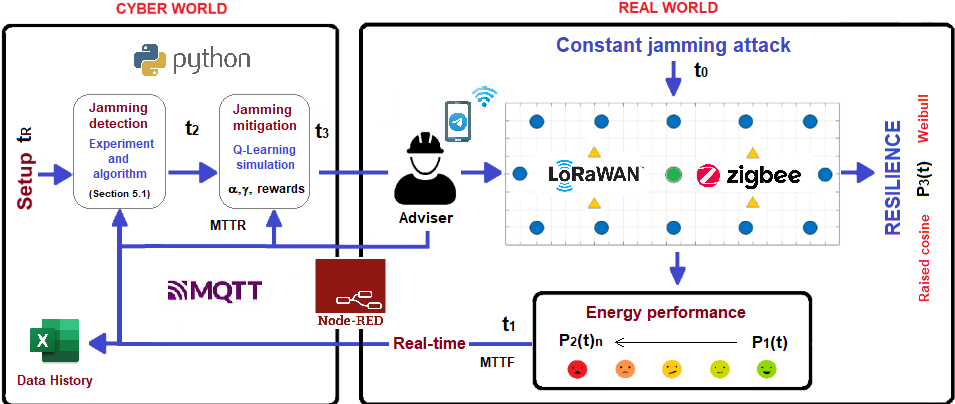
Figure 17. The worker-in-the-loop jamming attack control mechanism.